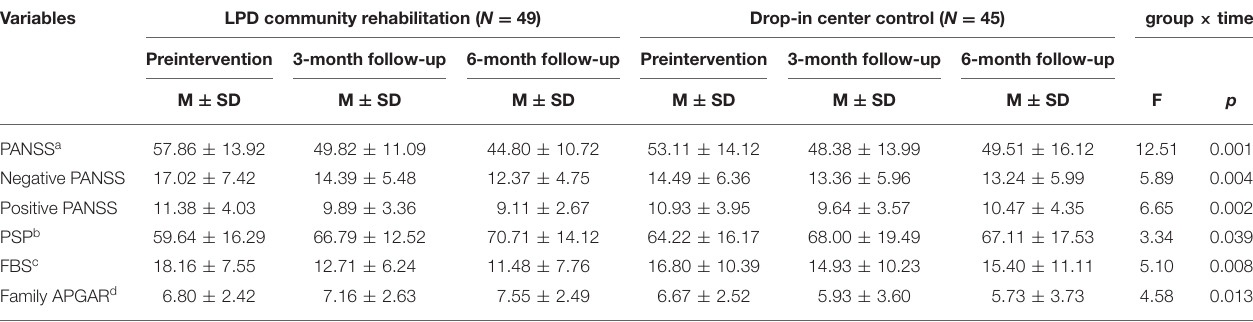
TABLE 3 | Means (standard deviations) and effect sizes for outcome variables for each treatment group before and after the intervention. Variables LPD community rehabilitation ( N = 49) Drop-in center control ( N = 45)